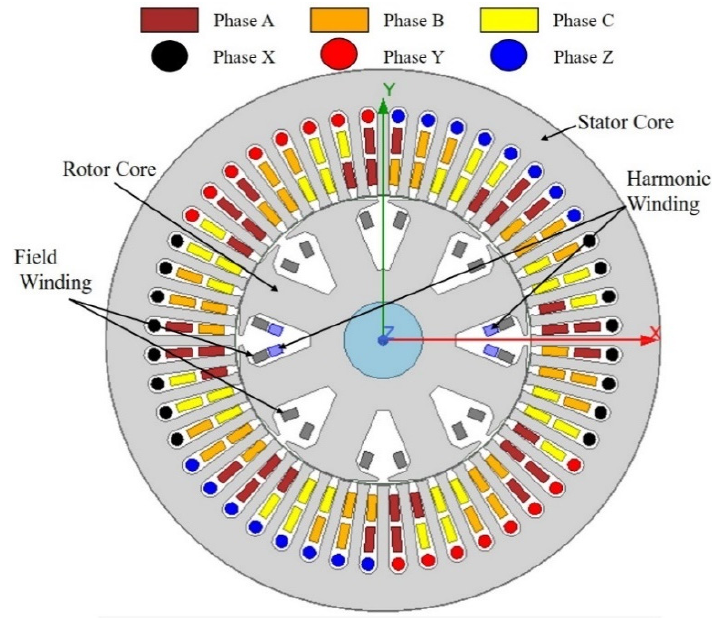
Figure 2. Machine layout for the proposed